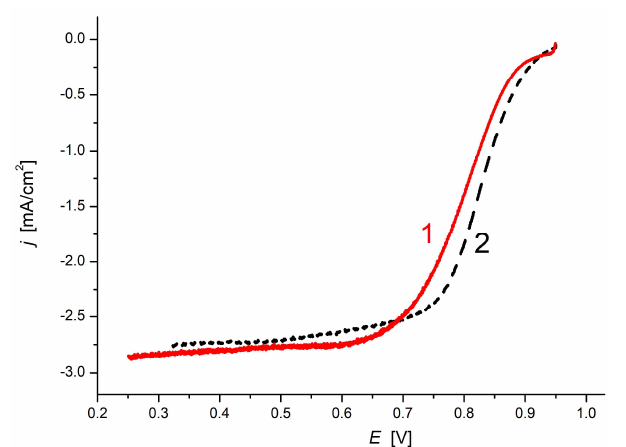
Figure 8. Linear potential sweep of CA sample (solid red line) and a 20 wt% Pt/C electrode (dashed black line) measured in O 2 saturated 0.1 M KOH solution with a rotating disk electrode (1225 rpm). Loadings: 100 µg/cm 2 , Sweep rate: 5 mV/s.